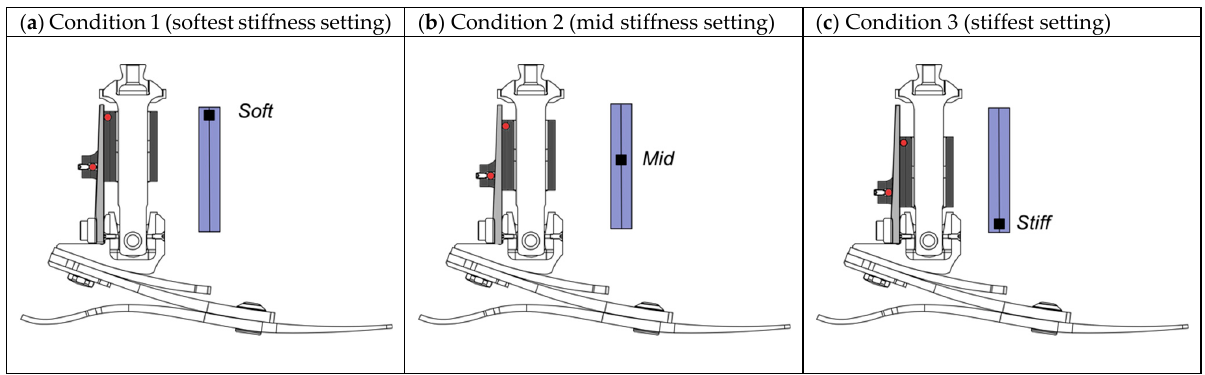
Figure 2. Schematic of leaf spring support for three stiffness settings for the VSA prosthetic foot: ( a ) condition 1—softest; ( b ) condition 2—mid; and ( c ) condition 3—stiffest.